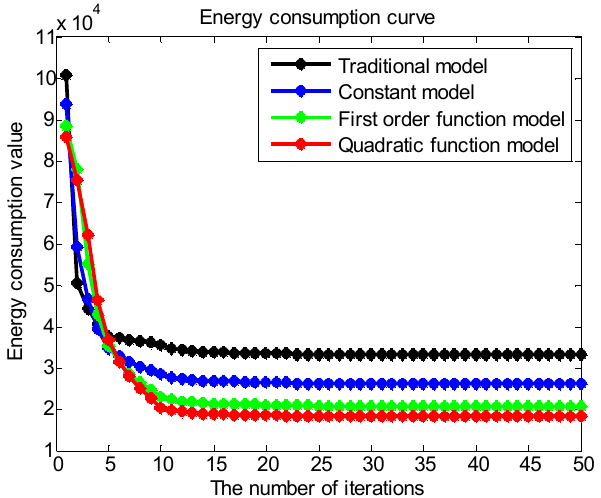
Figure 13. The relationship between the energy consumption and d.